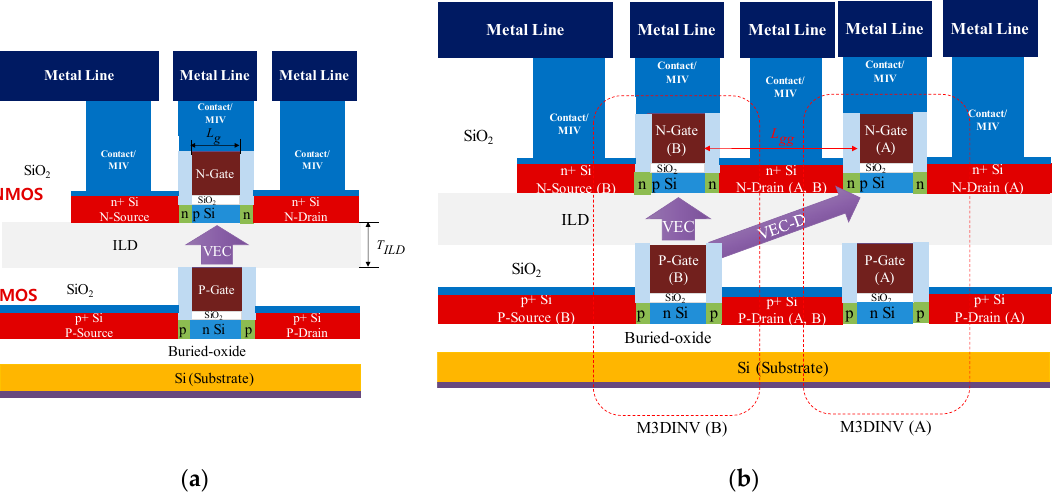
Figure 1. Schematics of two types of monolithic 3D integration (M3DI) cell structures. ( a ) monolithic 3D inverter (M3DINV) unit cell and ( b ) monolithic 3D NOR (M3DNOR) unit cell.